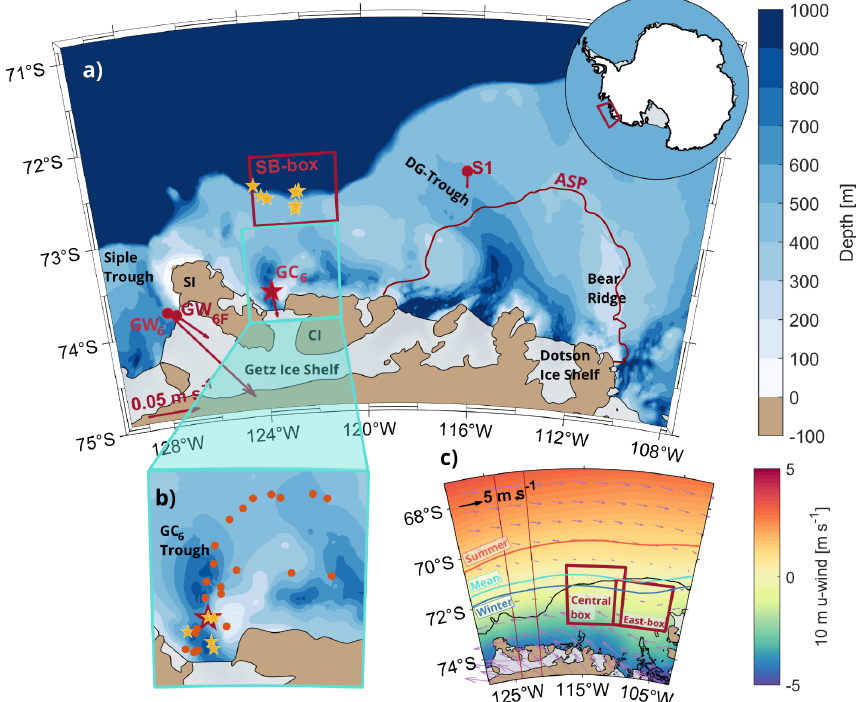
Figure 1. (a) Map of the Amundsen Sea with bathymetry (color scale) (IBCSO, Arndt et al., 2013) and ice shelf (gray) (Bedmap2, Fretwell et al., 2013). The location of the study region within Antarctica is indicated by a red box in the inset. The moorings GC 6 (red star), GW 6 , GW 6F , and S1 (red dots) are marked, with arrows denoting mean current averaged over depth and time. The velocity scale is given in the lower left corner. SI: Siple Island, CI: Carney Island, ASP: Amundsen Sea Polynya, and DG Trough: Dotson–Getz Trough. The outline of the ASP is based on data from January 2011 (Yager et al., 2012). (b) Detailed map of the GC 6 trough. Conductivity, temperature, and depth (CTD) stations from ship-borne surveys (yellow stars) are shown in (a) and (b) . CTD stations from an instrumented seal are marked with orange dots. (c) The mean wind field from 2001 to 2018 (ERA 5, color scale and purple arrows, see black arrow for scale) with mean zero- contours during the 17-year period (cyan), summer (red), and winter (blue). The thin meridional red lines indicate the meridional band used for estimating the latitude of the zero-contour north of GC 6 . The black contour is the 900-m isobaths. The red SB (a) , ASP, and East boxes (c) indicate regions used for averaging ocean surface stress. The SB box is also used for estimating cumulative Ekman pumping